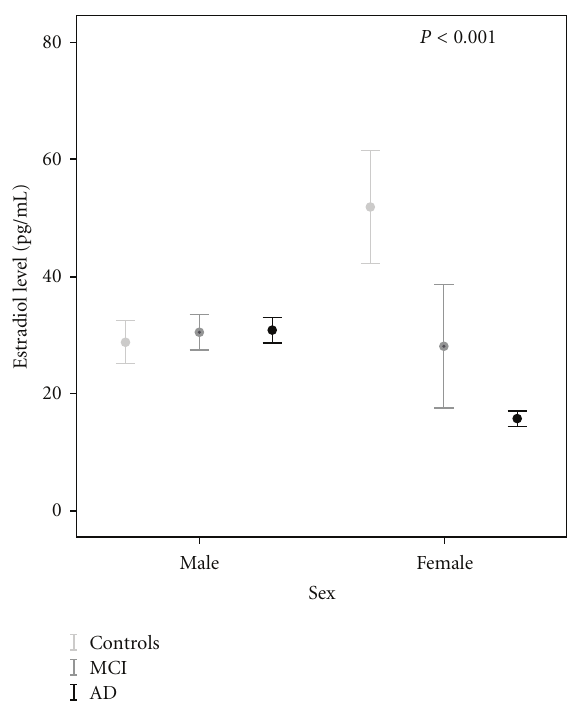
Figure 1: Di ff erences of estradiol levels in controls, MCI, and AD patients (gender considered